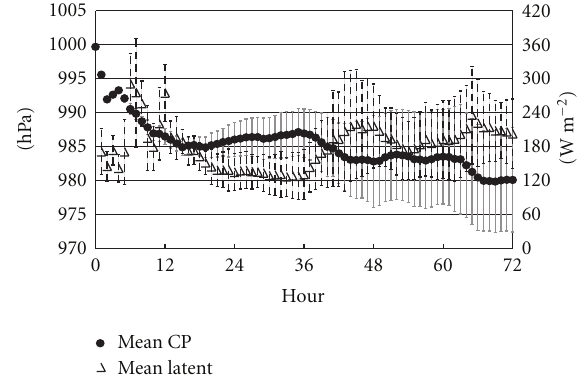
Figure 9: Time series of mean central pressure (CP, left axis) and mean latent heat flux (Wm − 2 , right axis) and their standard